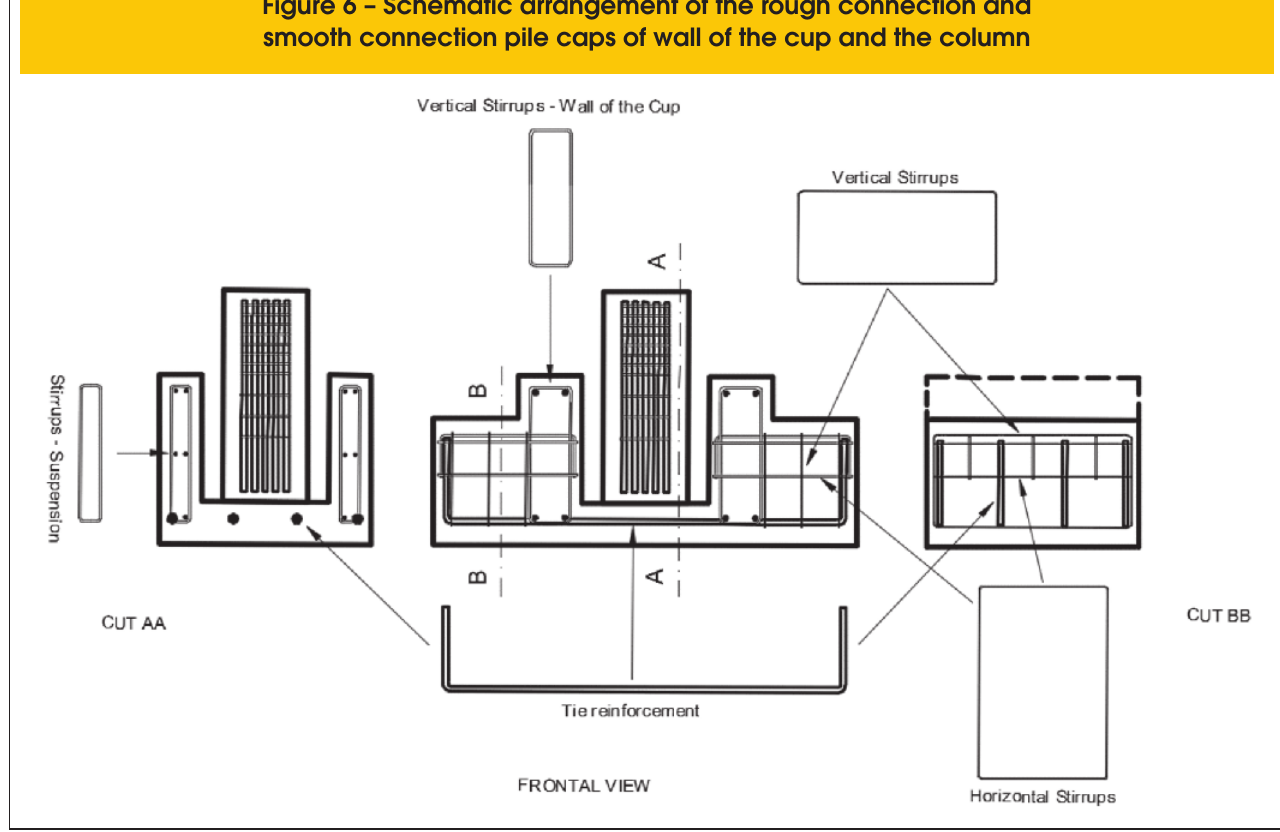
Figure 6 – Schematic arrangement of the rough connection and smooth connection pile caps of wall of the cup and the